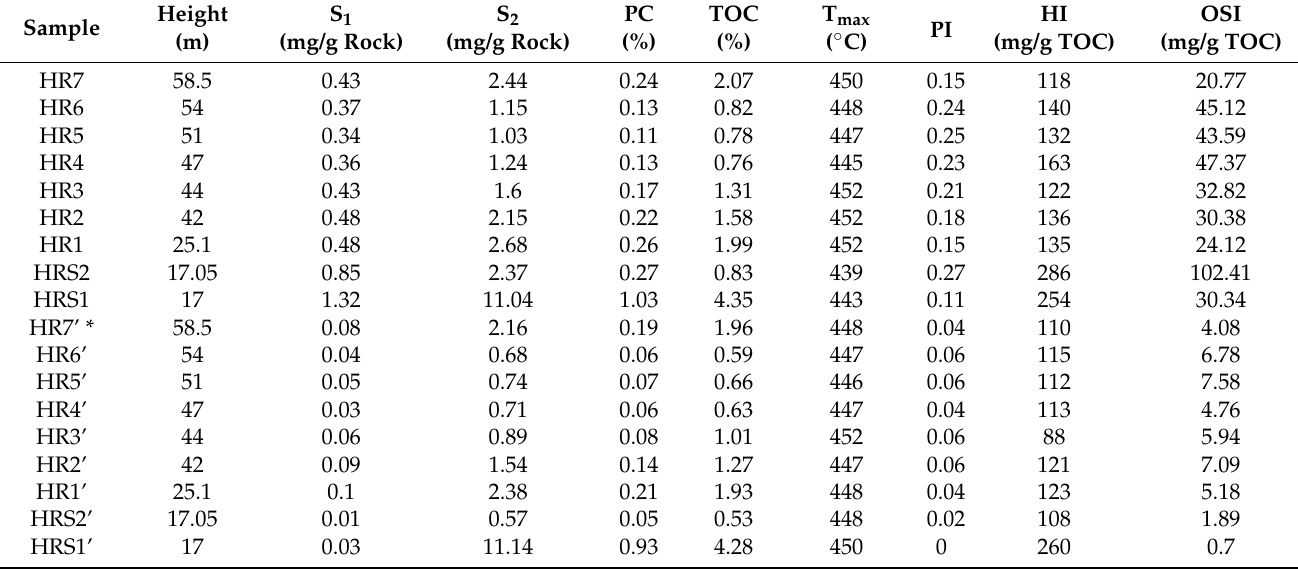
Table 1. Rock-Eval pyrolysis analysis results of the unextracted and extracted samples from High- wood River